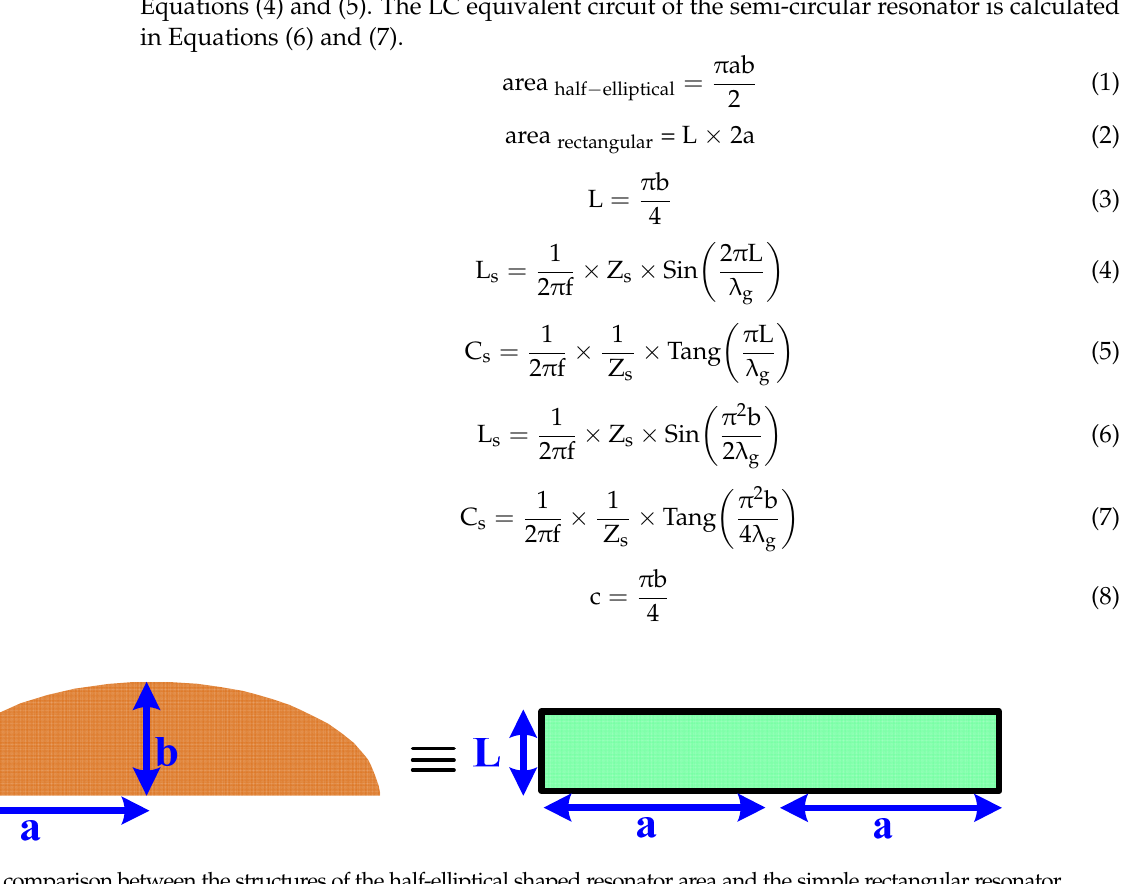
Figure 4. The comparison between the structures of the half-elliptical shaped resonator area and the simple rectangular resonator.